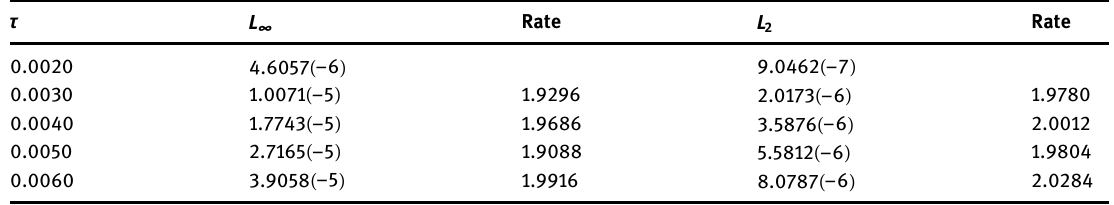
Table 13: L 2 , L ∞ errors and rate at = T 0.1 and = h 0.008 by the HOC - LOD scheme for variable τ for Example 6